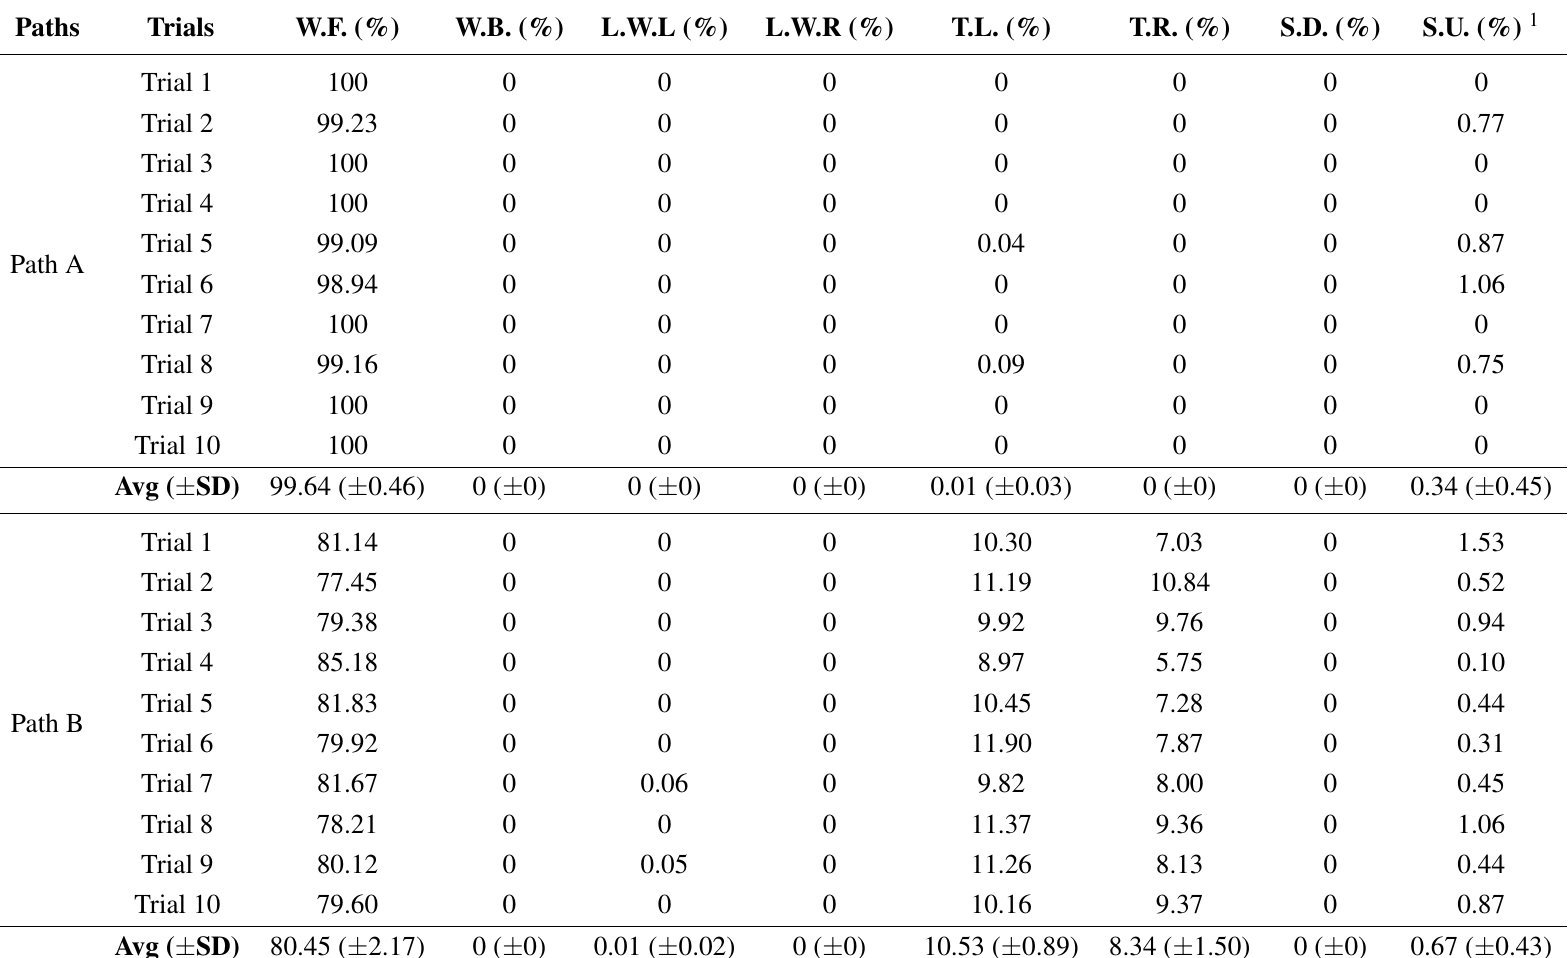
Table 6. Percentages of recognition of each foot movement pattern in the two